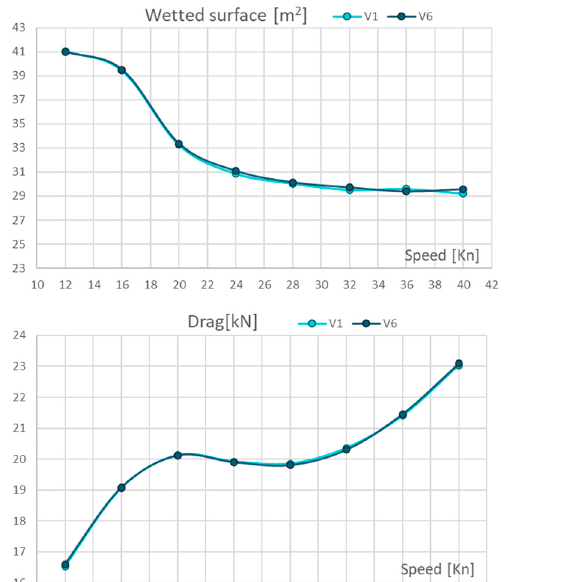
Figure 7. Comparison of pressure distribution on the hull bottom for V1 and V6 at different speeds.